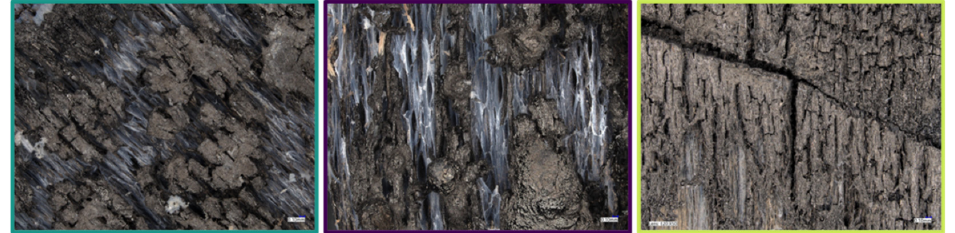
10 Figure 10. Observations of cone calorimeter residues: Reference ( left ), YB treated PEI: SPA 1:2 ( center ), and YB treated PEI: SPA 1:3 ( right ).